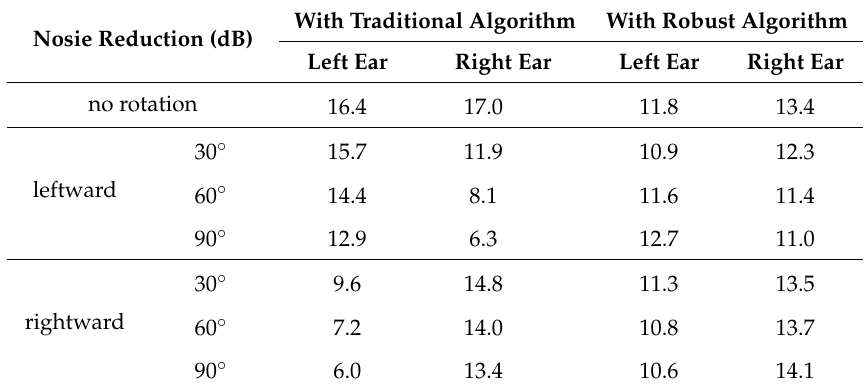
Table 1. Noise control performance when head rotates with and without the robust algorithm. With Traditional Algorithm With Robust Algorithm Nosie Reduction (dB) Right